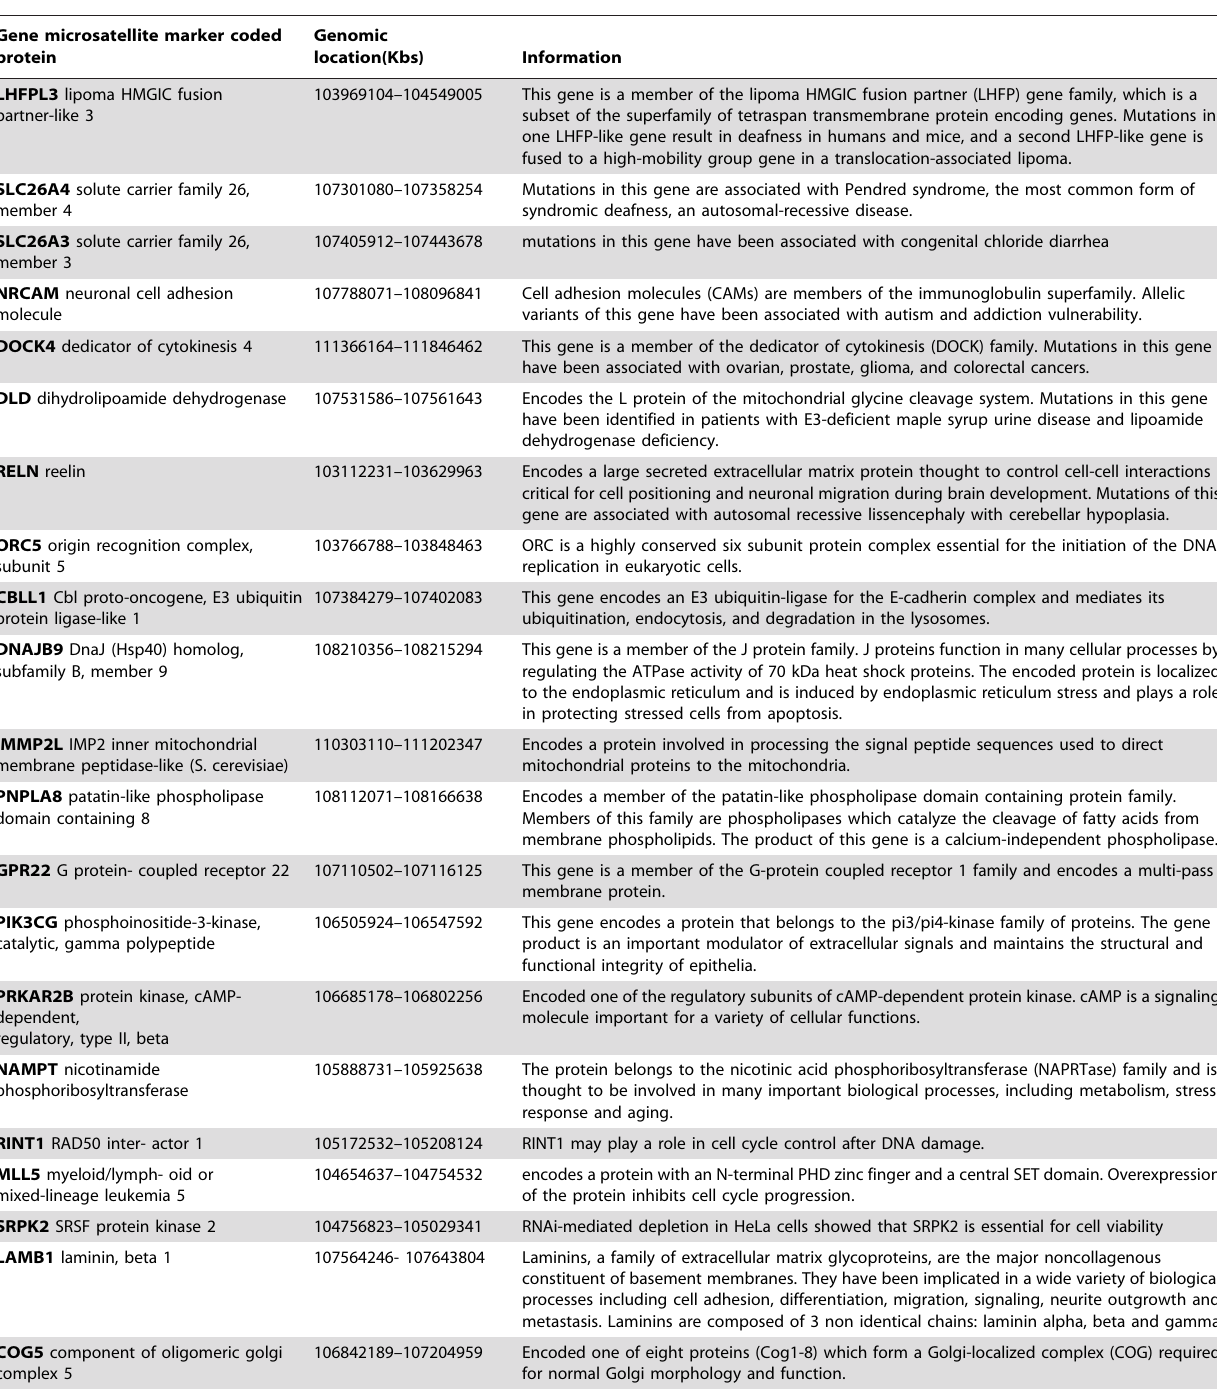
Table 2. The known or putative functions of the candidate genes in this refined linked area.